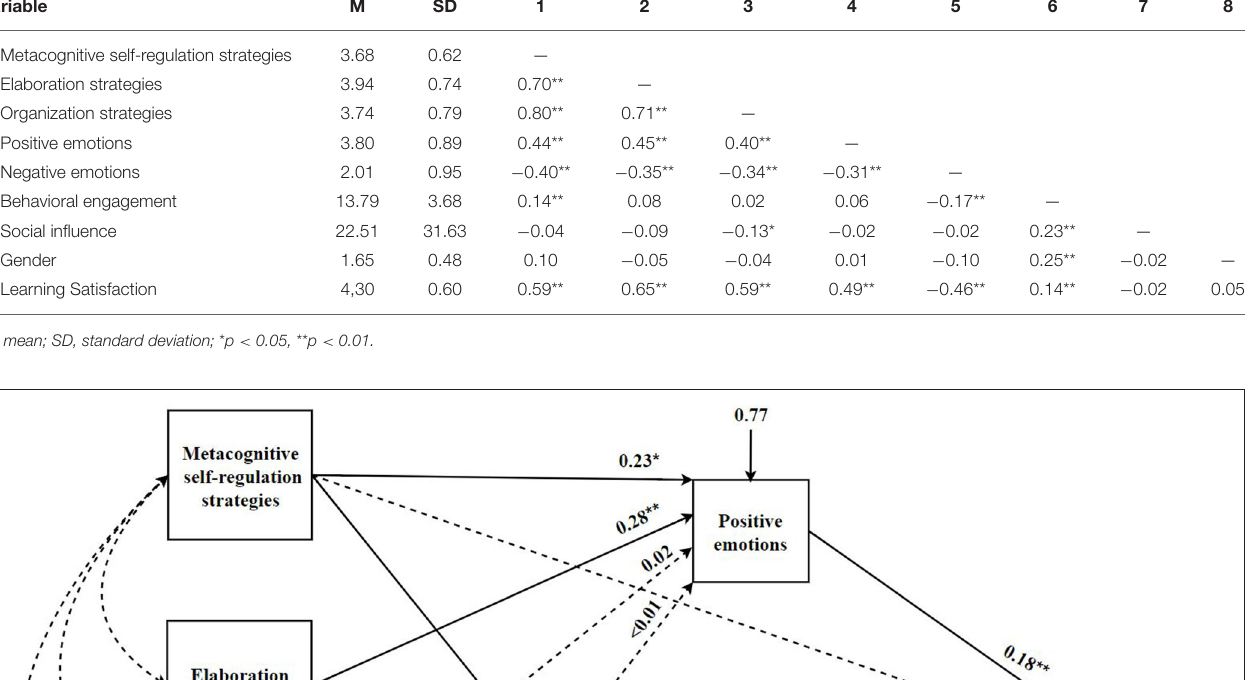
= 6, χ 2 /df = 2.73, p < 0.05; RMSEA = 0.07, CFI = 0.99, TLI = 0.95). The significance of the mediating effect was analyzed by the bias correction Bootstrapping method ( Table 3 ). If the